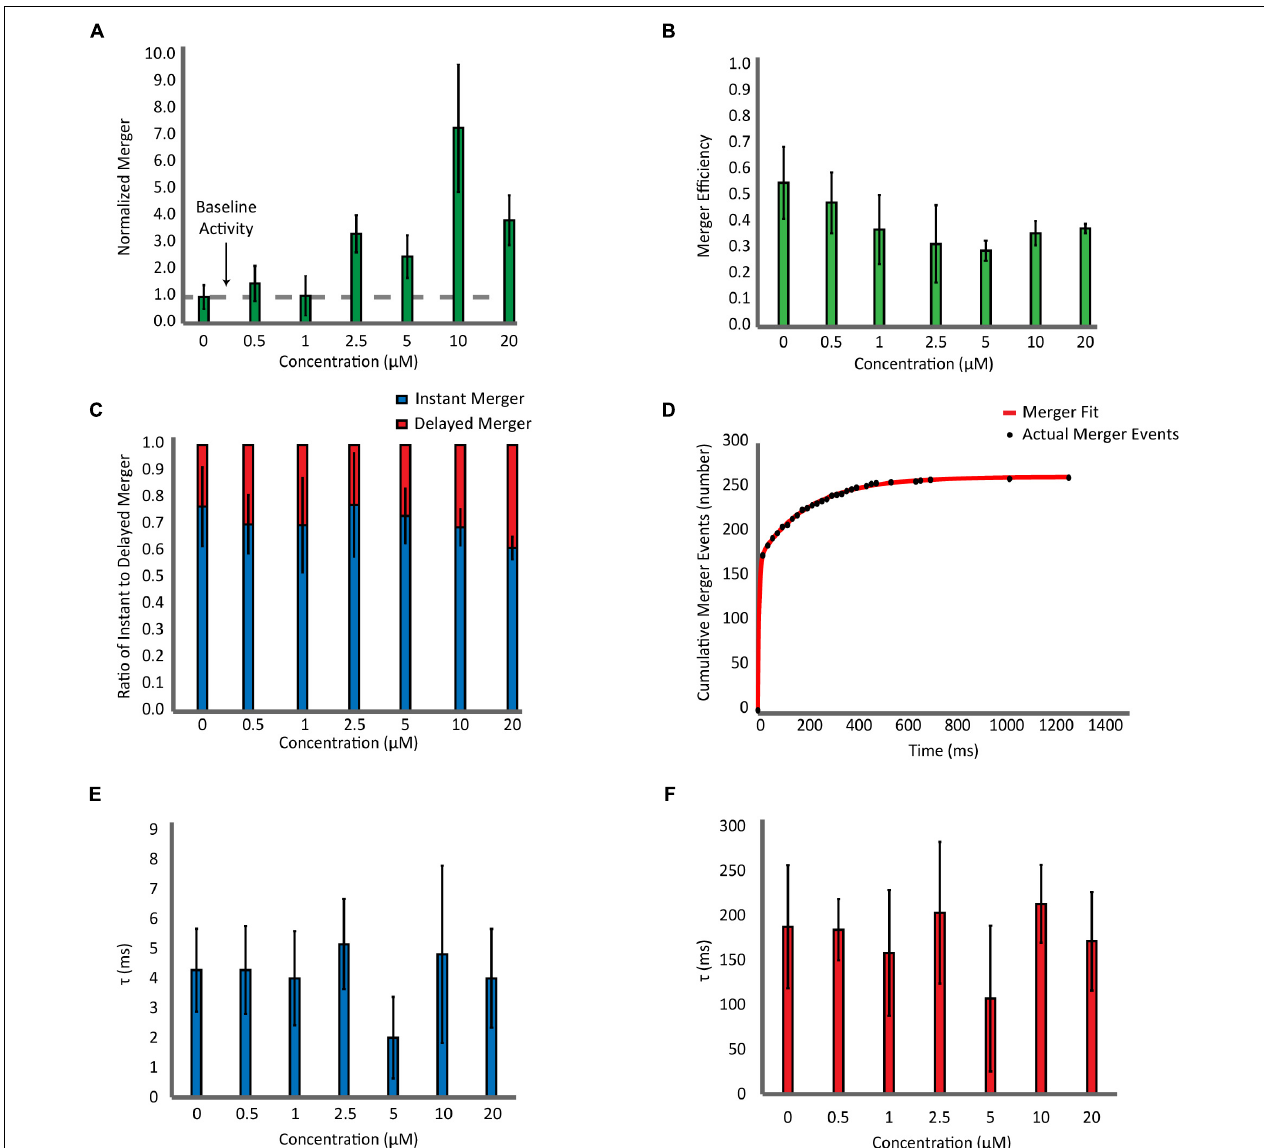
FIGURE 3 | Effect of α S on SNARE-dependent membrane fusion is mainly on docking with little influence on the dynamics of bilayer merger. (A) Analysis of the bilayer merger dynamics with twice purified α S. The number of merger events at various α S concentrations are normalized with respect to events without α S. The dashed line represents the membrane merger activity of SNAREs without α S. (B) Analysis of the bilayer merger efficiency of twice purified α S. The efficiency is calculated as the number of merger events divided by the number of docking events. (C) Instant merger vs. delayed merger. Instant merger events display lipid-diffusion in under 20 ms and delayed merger events are any that take longer than 20 ms. (D) Representative cumulative plot of bilayer merger events with twice purified α S. The red line is the double exponential fit to the data of merger events. (E) Plot of time constants for instant merger events. (F) Plot of time constants for delayed merger events. The total of 1,247 merger events from 82 independent recording were included in the fitting